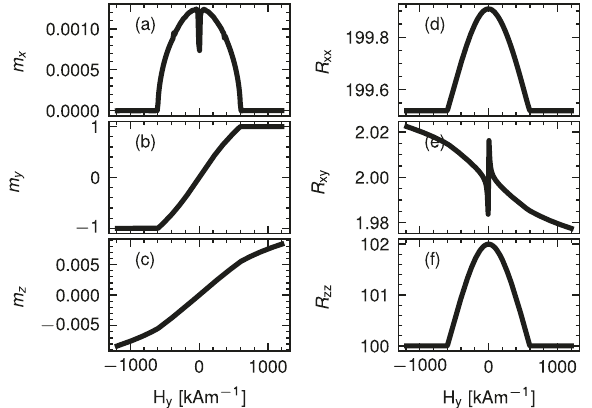
Fig. 2 Steady-state simulations of the Co/Ru/Co system with the transverse applied fi eld. M ( H ) a – c and R ( H ) d – f loops simulated with parameters taken from Supplementary Table 1. The magnetic moment is normalised to unity, whereas the SMR, AMR, and GMR magnitudes are set to − 0.24, − 0.045, and 2 Ω , respectively (note that m y and m z components show very little variation with the applied fi